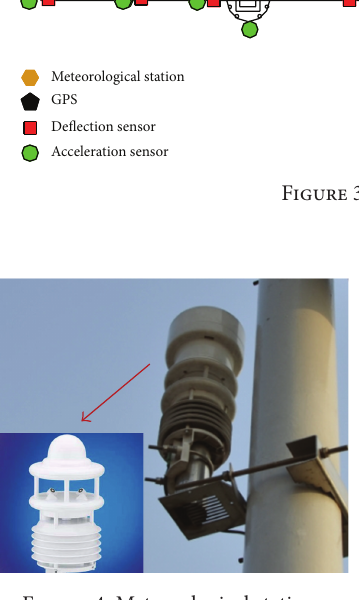
Figure 4: Meteorological